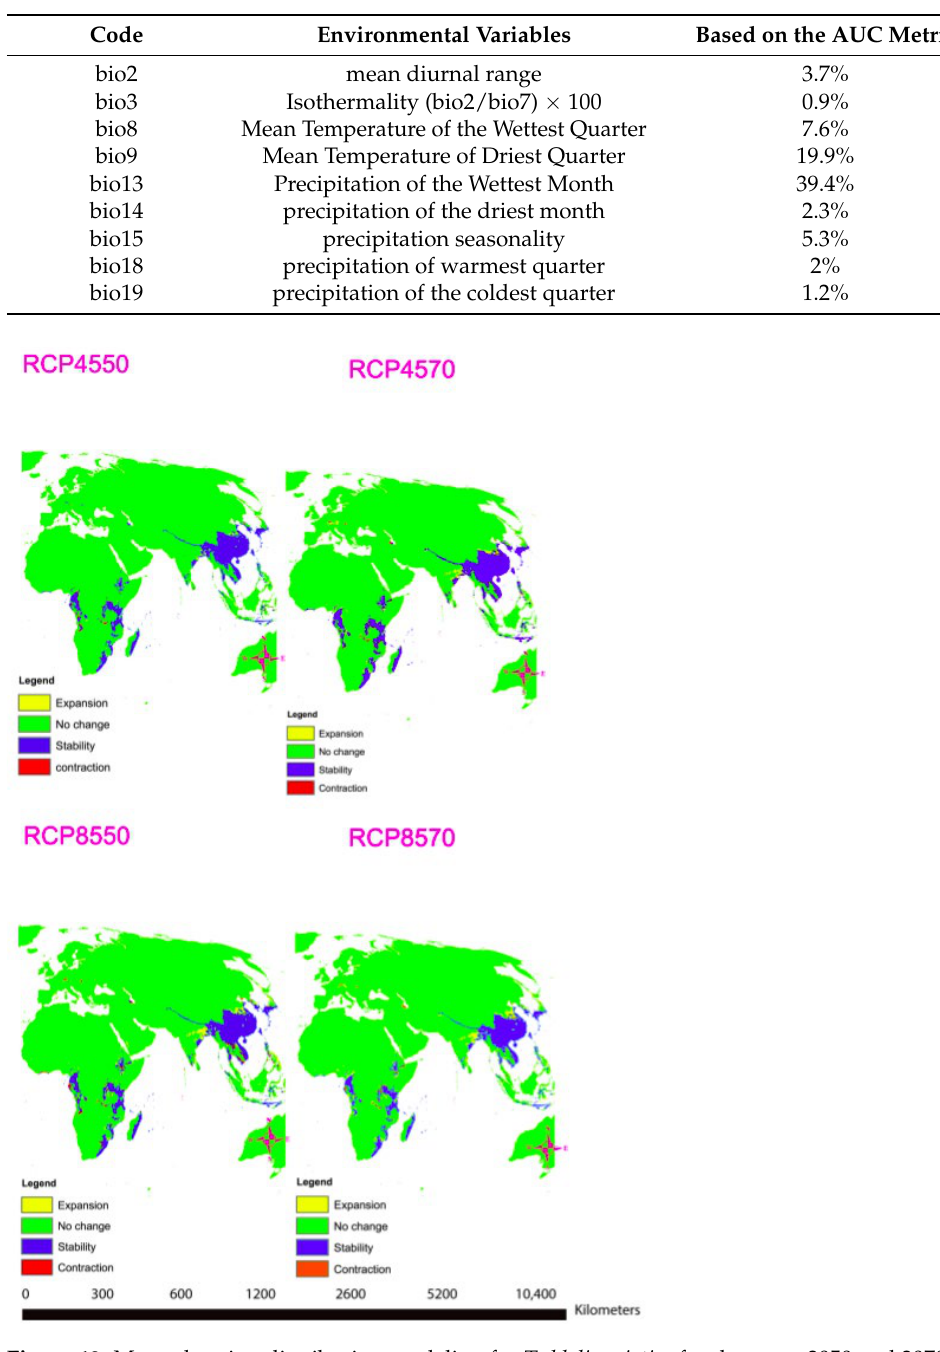
Table 3. Relative variable importance percentage.